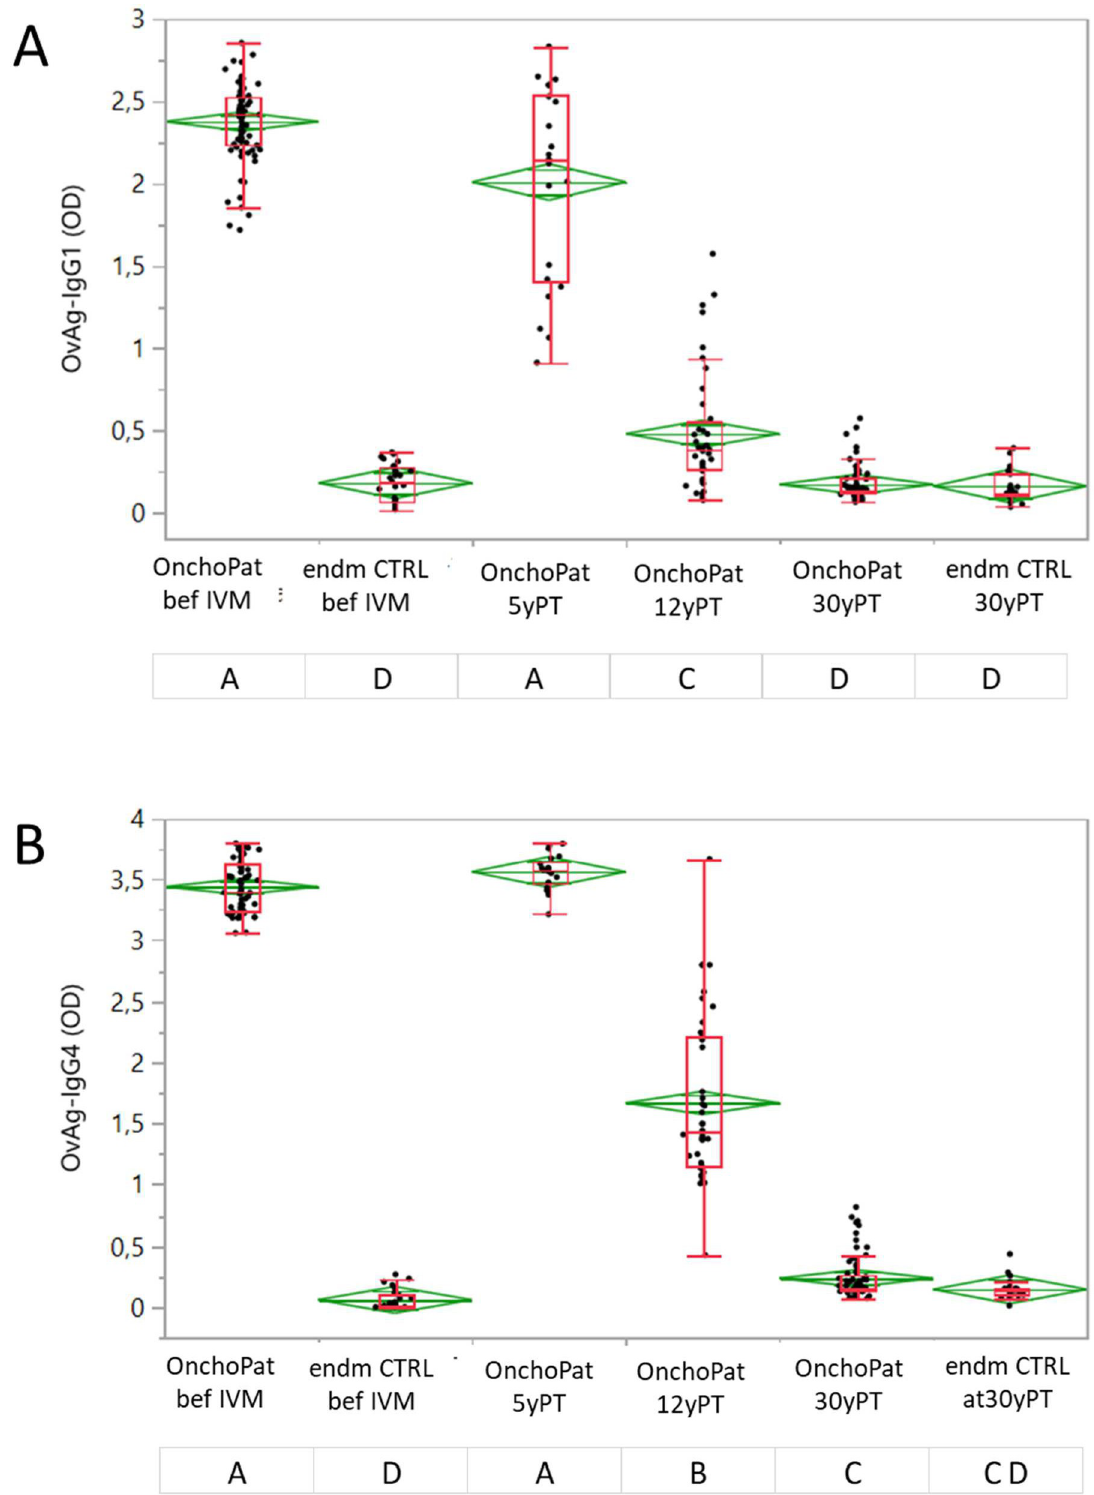
Fig 1. Onchocerca volvulus antigen specific IgG1 ( A ) and IgG4 ( B ) responses (OD) in onchocerciasis patients (OnchoPAT) and endemic controls (endmCTRL). The ivermectin treatment was applied annually since year 1989 and the OvAg specific IgG1 and IgG4 responses were investigated in onchocerciasis patients (OnchoPAT) at before ivermectin (beforeIVM, n = 83, 23femaler/60male), 5 years post